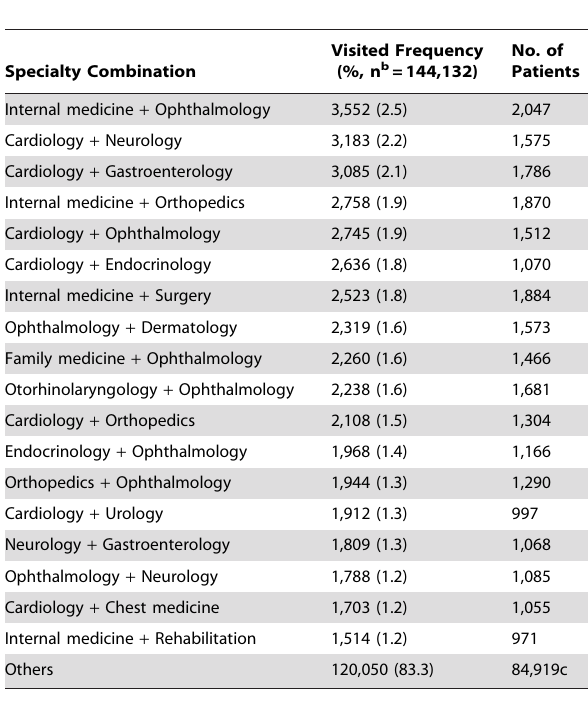
Table 4. Patterns of two-specialty combinations in one-stop visits a in 2005